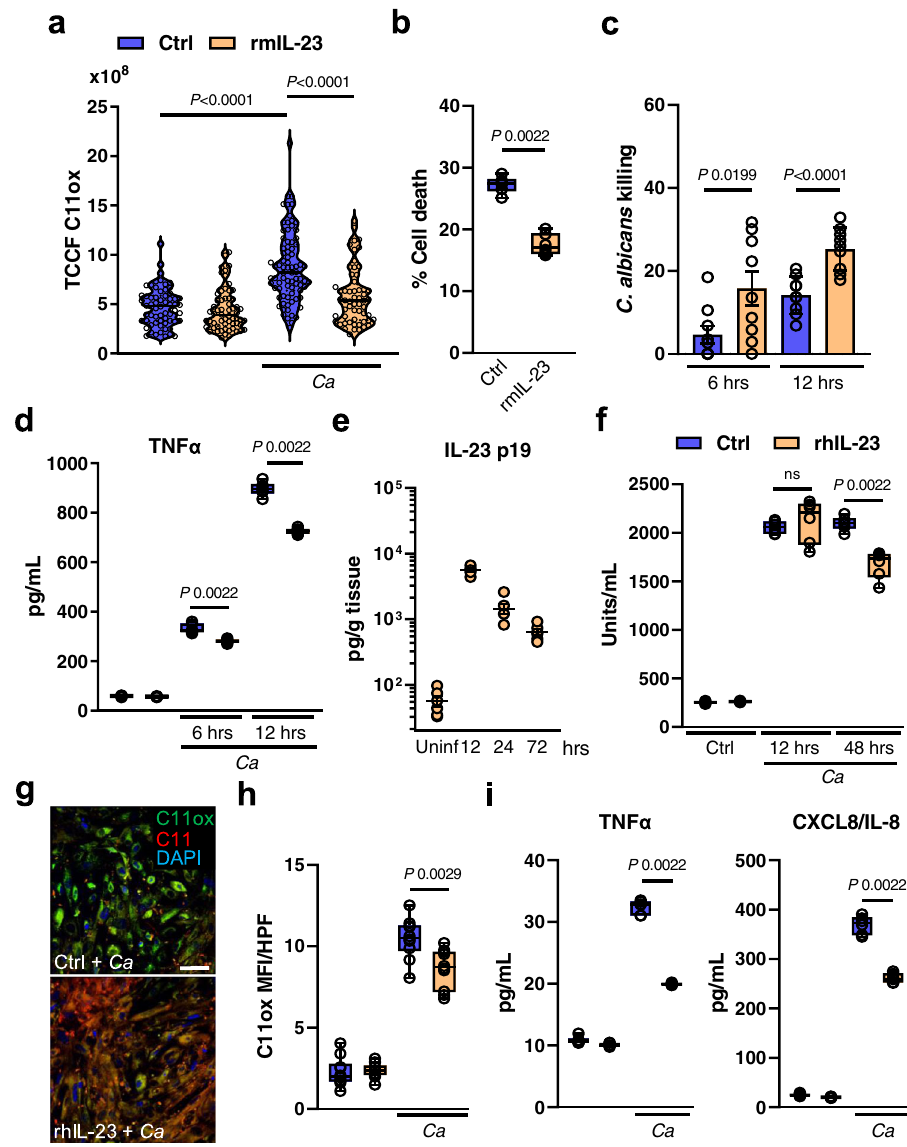
Fig. 6 | IL-23 prevents ferroptosis in macrophages and renal tubular epithelial cellduring C.albicans infection.a BM-derivedmacrophageswereinfectedwith C. albicans (MOI 1) for 4h in the presence and absence of rmIL-23. Total C11ox fl uorescence was quanti fi ed. Individual cells ( N =62 cells for Ctrl; N =60 cells for Ctrl+rmIL-23; N =79 for Ctrl+ Candida ; N =57 for Candida +rmIL-23; combined dataofthreeindependentexperiments)wereidenti fi edand total fl uorescencewas measured using ImageJ. Two-tailed Mann – Whitney Test. Violin plot with median and quartiles. b BM-derived macrophages were treated with rmIL-23 for 1h fol- lowed by interaction with C. albicans (MOI 5) for 4h. PI + (dead) cells were deter- mined by gating on F4/80 + cells. N =3; duplicate. Two-tailed Mann – Whitney Test. Box-and-whiskerplotsindicatingmedian,25th/75thpercentiles,andtheminimum/ maximum values. c Macrophages-mediated C. albicans killing in the presence and absence of rmIL-23. MOI 1. N =3 in triplicate. Bar graphs show mean±SEM. Two- tailedMann – WhitneyTest. d TNF α secretionofBM-derivedmacrophagesduring C. albicans infection (MOI 1) for indicated time points. N =3, duplicate. Box-and- whisker plots indicating median, 25th/75th percentiles, and the